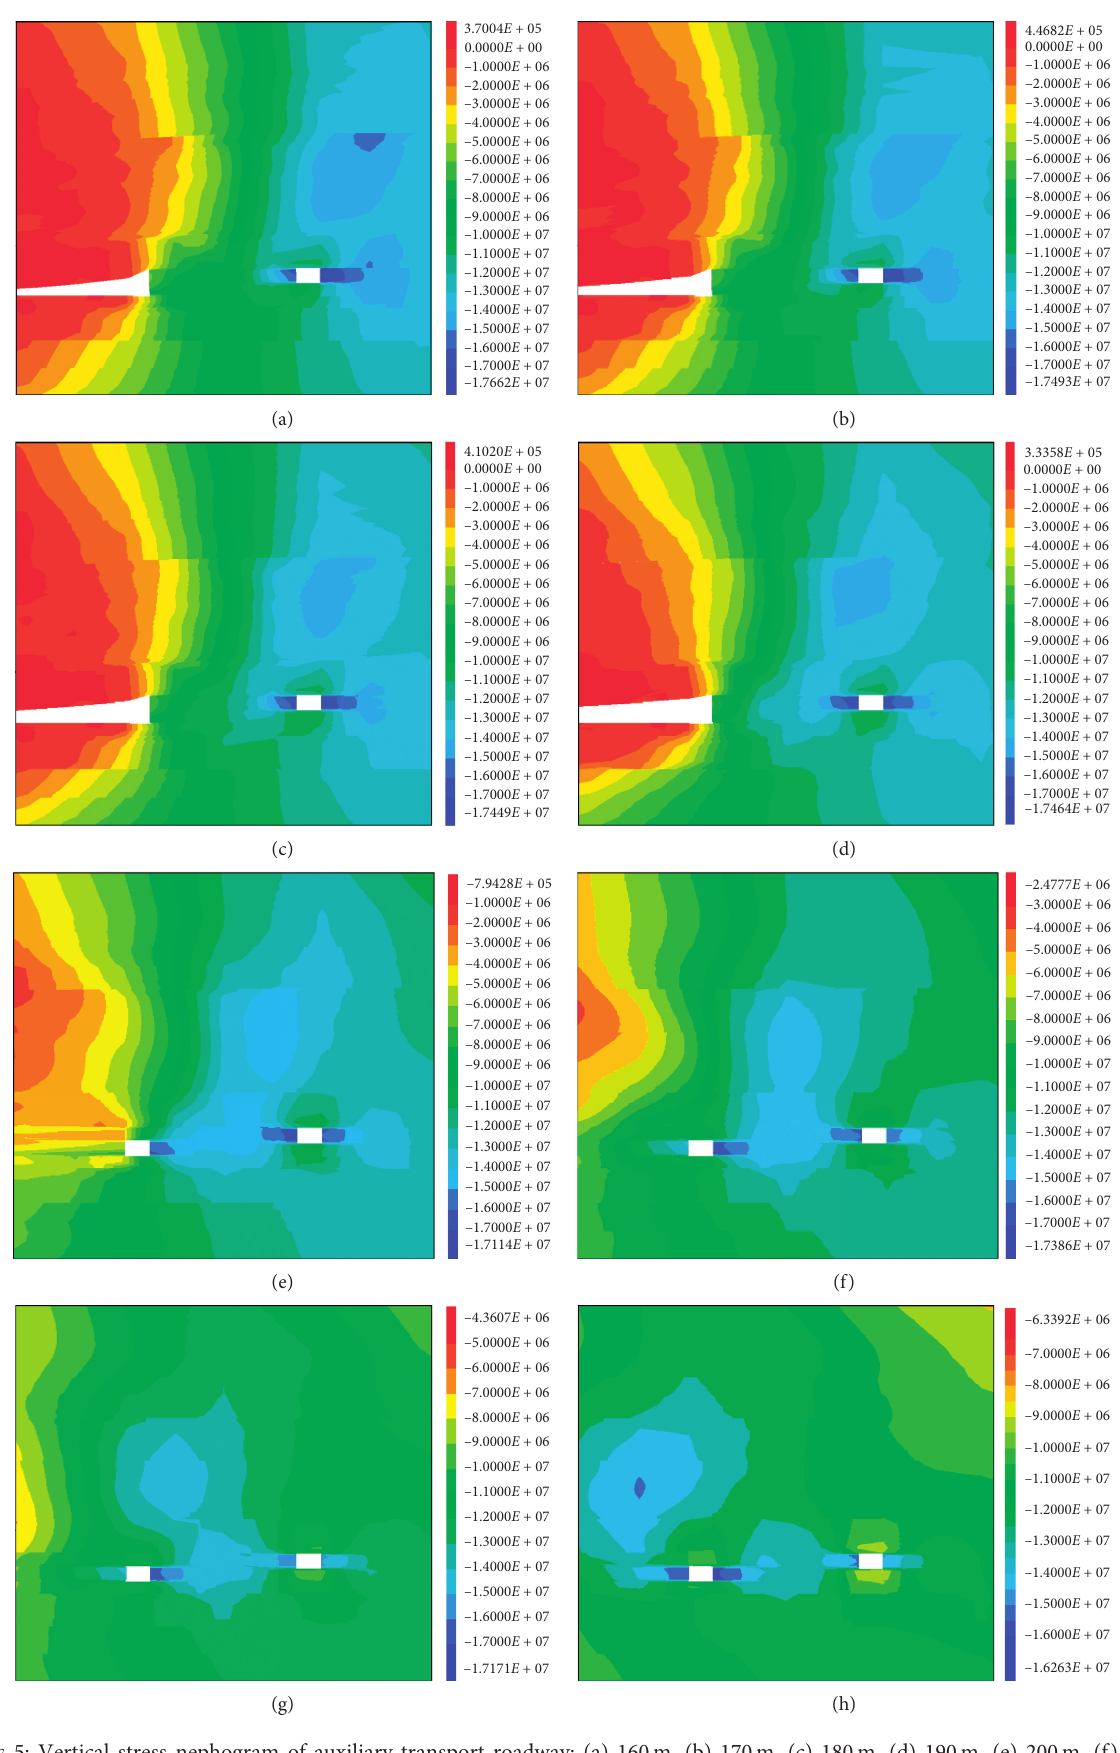
Figure 5: Vertical stress nephogram of auxiliary transport roadway: (a) 160m. (b) 170m, (c) 180 m, (d) 190m, (e) 200m, (f) 210 m, (g) 220m, and (h)